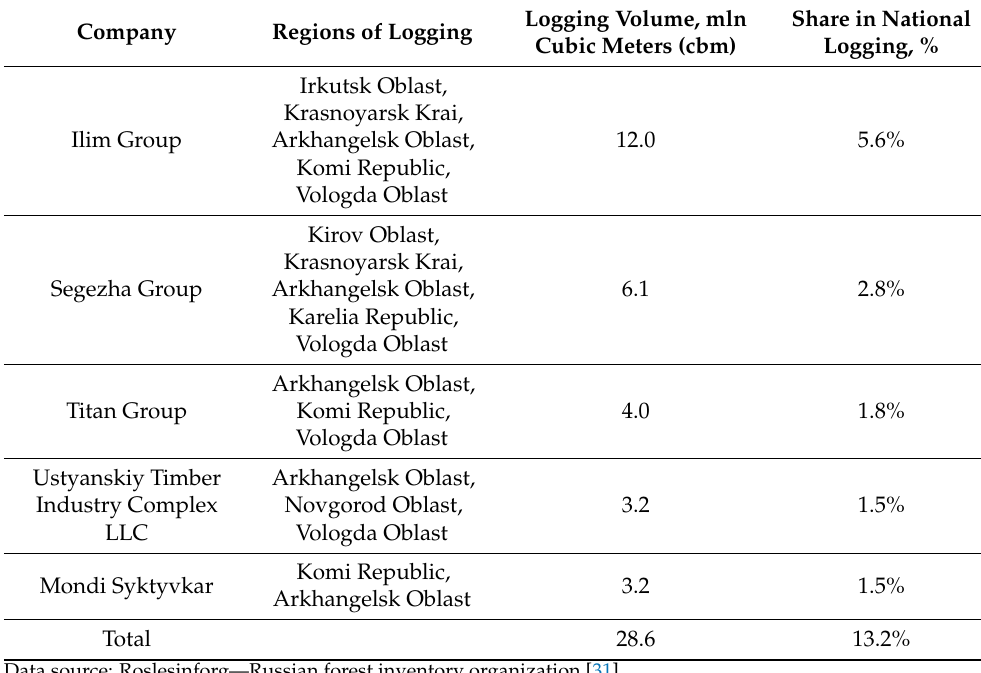
Table 1. The top-five logging companies in Russia, 2020. Company Regions of Logging